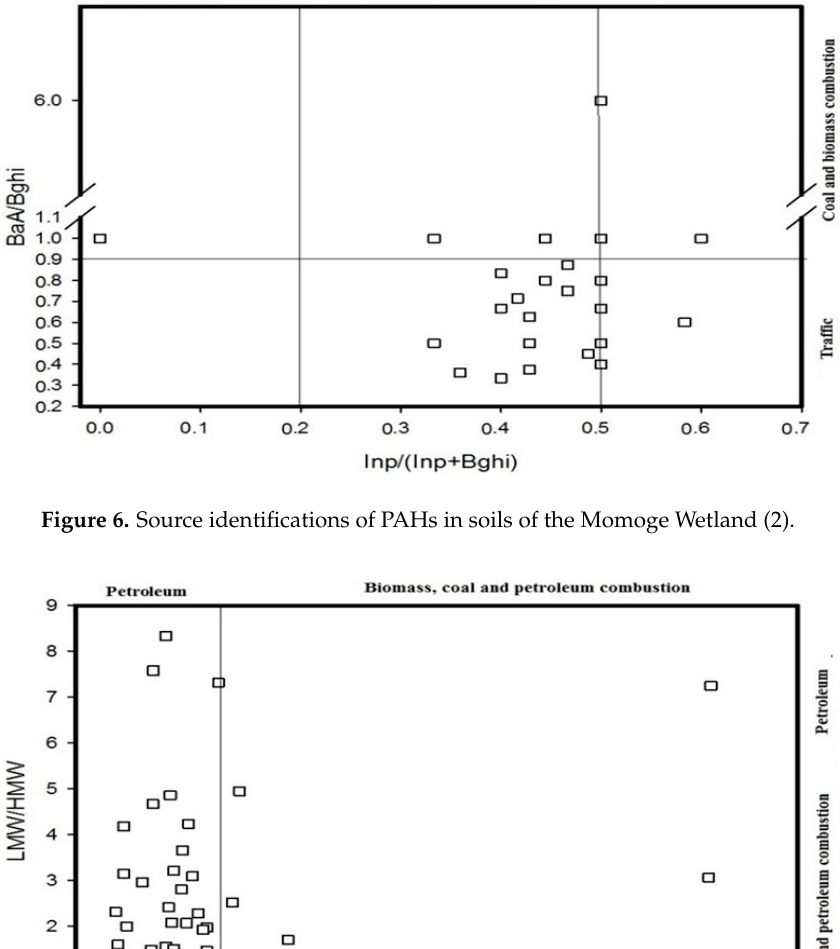
Figure 5. Source identifications of PAHs in soils of the Momoge Wetland (1).